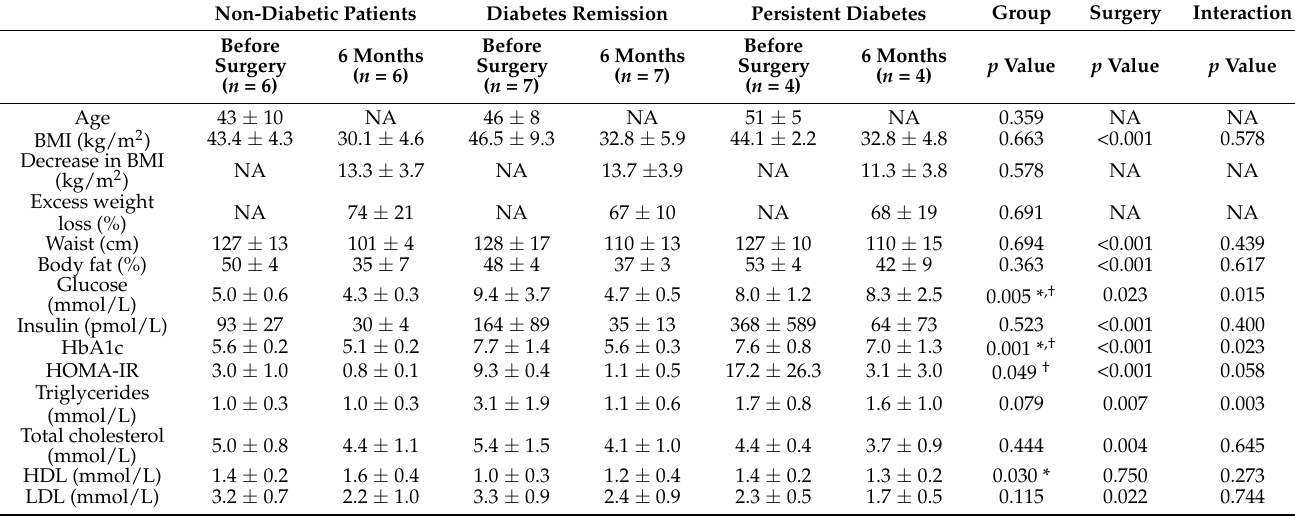
Table 1. Clinical and biochemical characteristics of subjects before and 6 months after bariatric surgery. Non-Diabetic